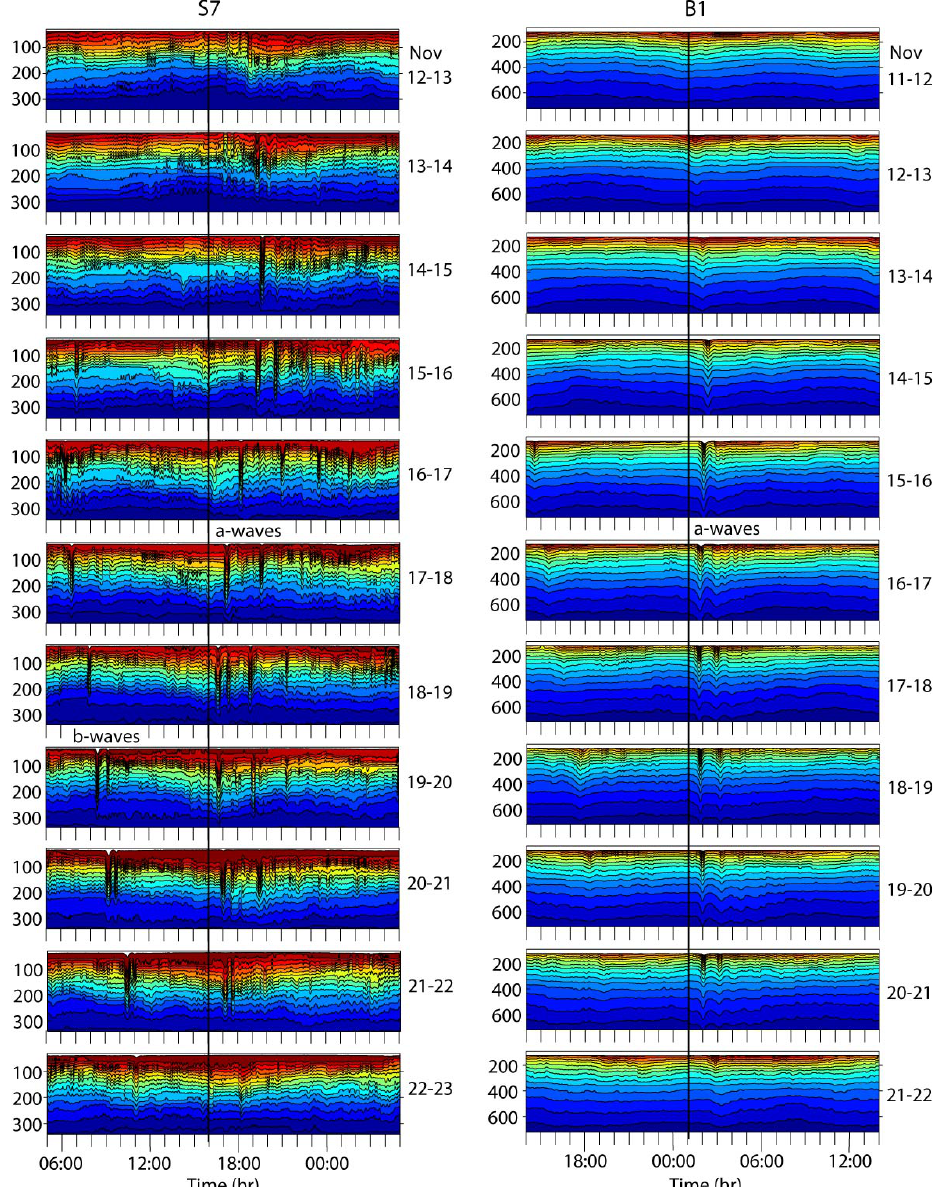
Fig. 4. Daily stack plots of temperature at B1 (right) and S7 (left) during 11–23 November 2005. The plots have been offset vertically by one day to account for the travel time between moorings, so that the same wave is depicted in the same horizontal panel of each column. A comparison of the right and left panels therefore shows the wave evolution from B1 to S7. The a- and b-wave arrivals are labeled. The vertical lines are a visual aid for aligning the wave